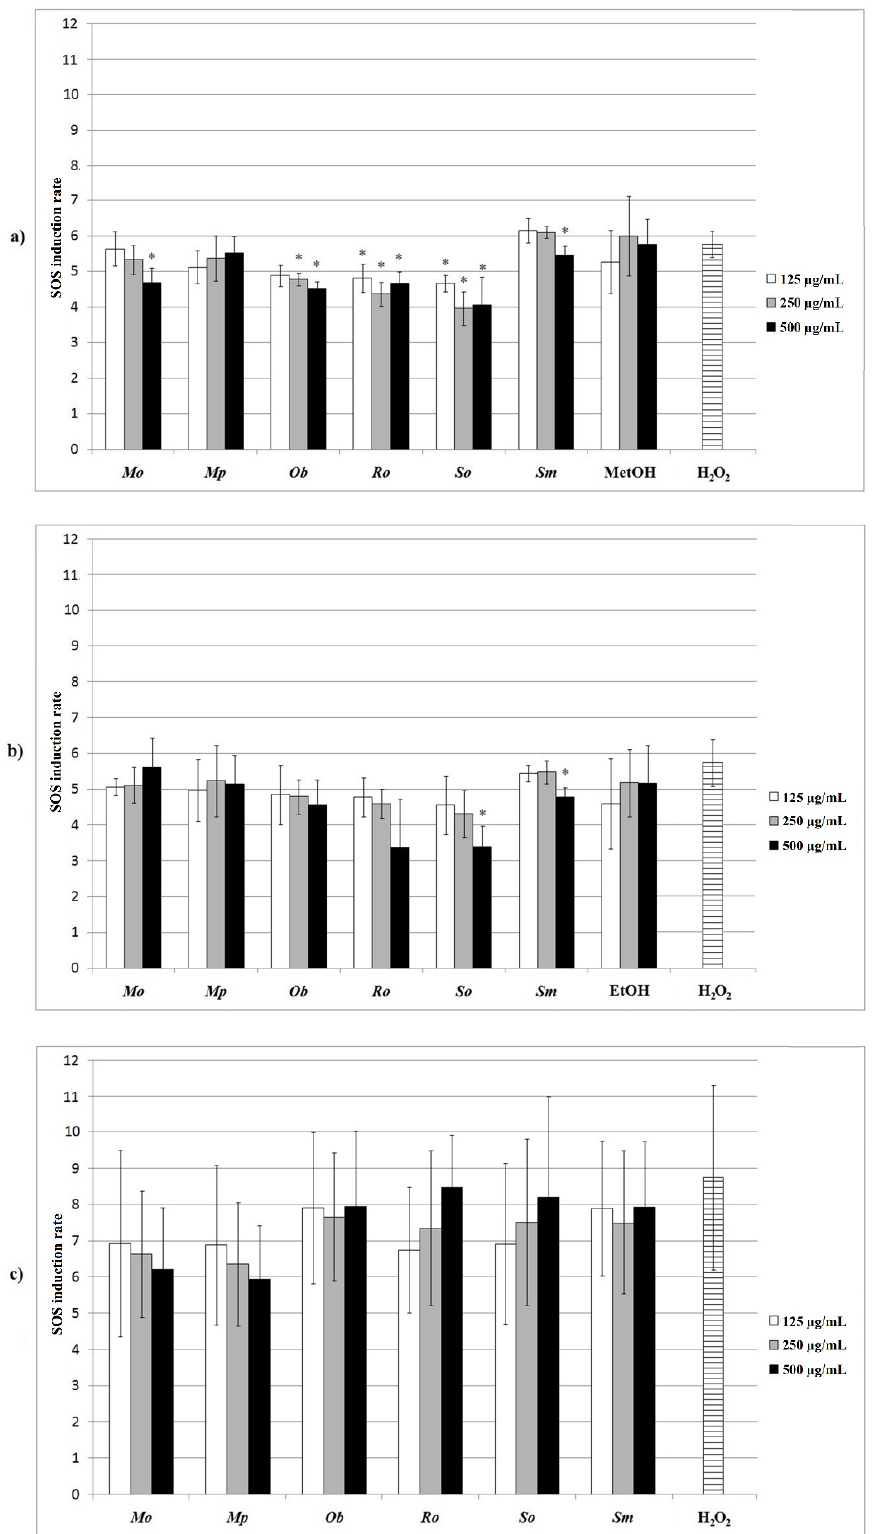
Figure 2. The impact of ( a ) methanolic extracts; ( b ) ethanolic extracts; ( c ) aqueous extracts, at 125, 250, and 500 µg/mL on the induction ratio of SOS response in SOS/ umuC test. MetOH and EtOH— controls for methanol and ethanol, respectively.* p < 0.05—statistically significant decrease of DNA damage in comparison with the negative control (H 2 O 2 ).